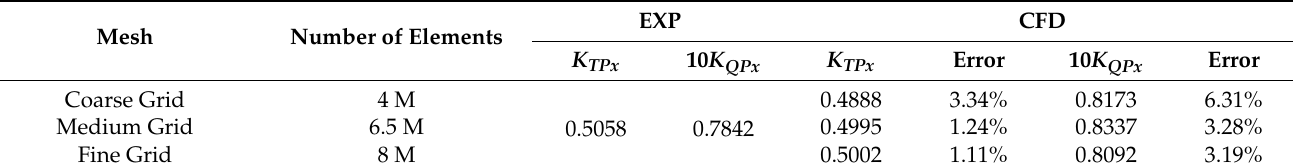
Table 2. Convergence analysis of the grid numbers.